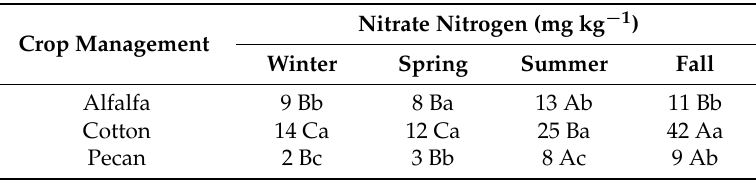
Table 5. Nitrate nitrogen as a function of crop management practices and sampling dates.